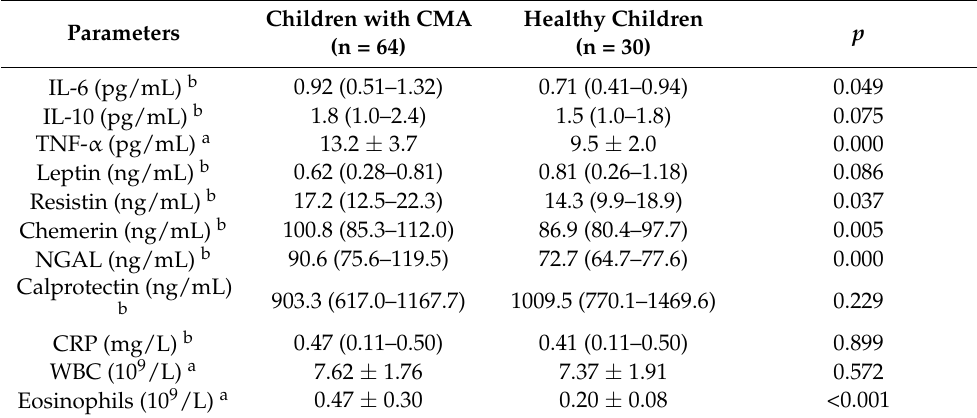
Table 2. Biochemical parameters associated with inflammation in children with CMA and healthy children.